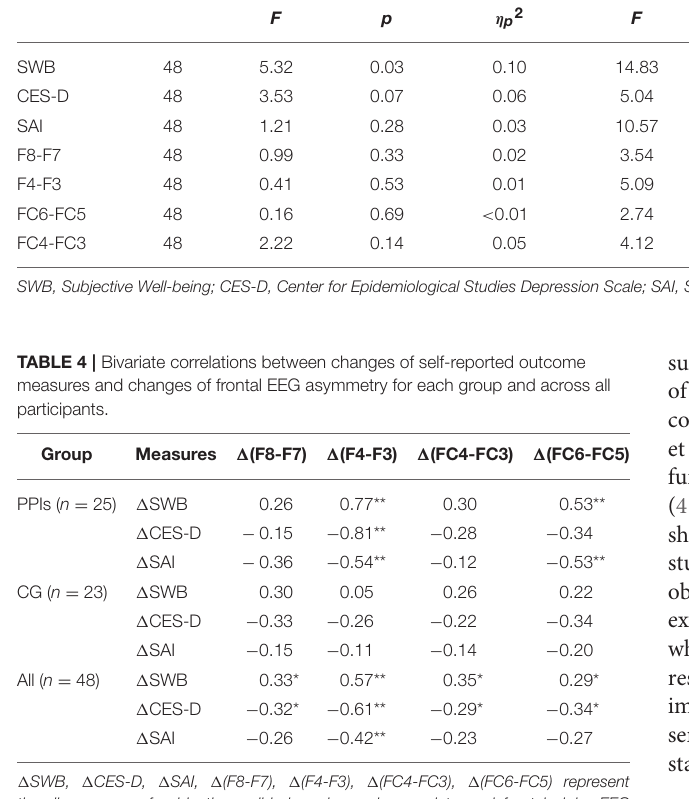
TABLE 3 | Repeated measurement analysis of variance on groups (the training group and control group), and time periods (pre-test, post-test) for subjective well-being, depression and anxiety. N Within subject effect Time × Group Between subject effect